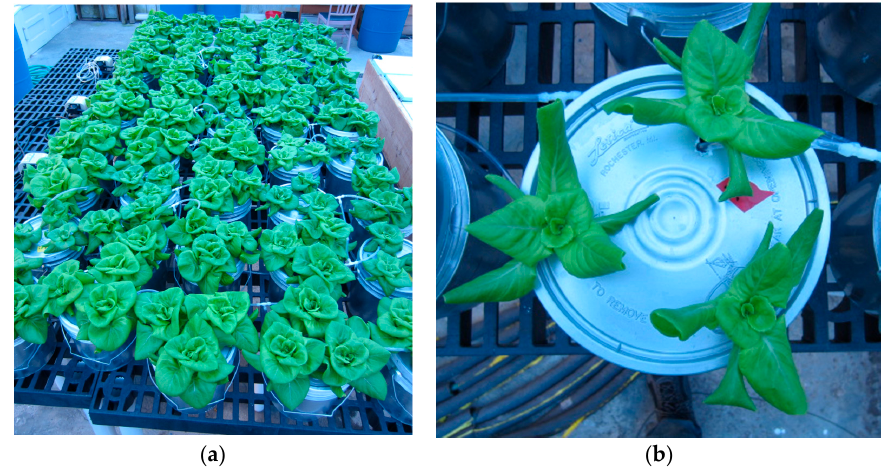
Figure 2. The experimental bucket system, showing: ( a ) the entire system; ( b ) an individual